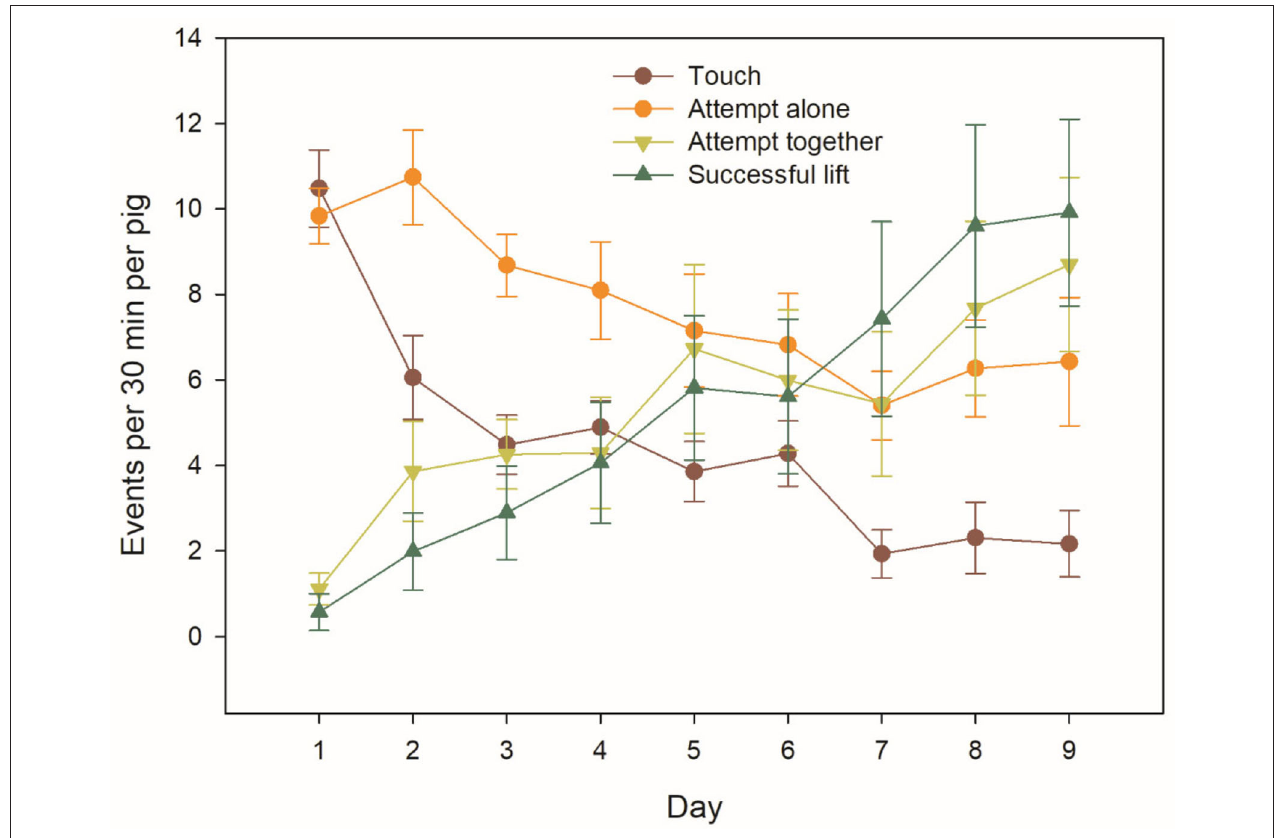
FIGURE 3 | Behavioural interactions with the apparatus over the testing days, based on group averages ( n = 8) of individual pig behaviour. The bars represent the standard